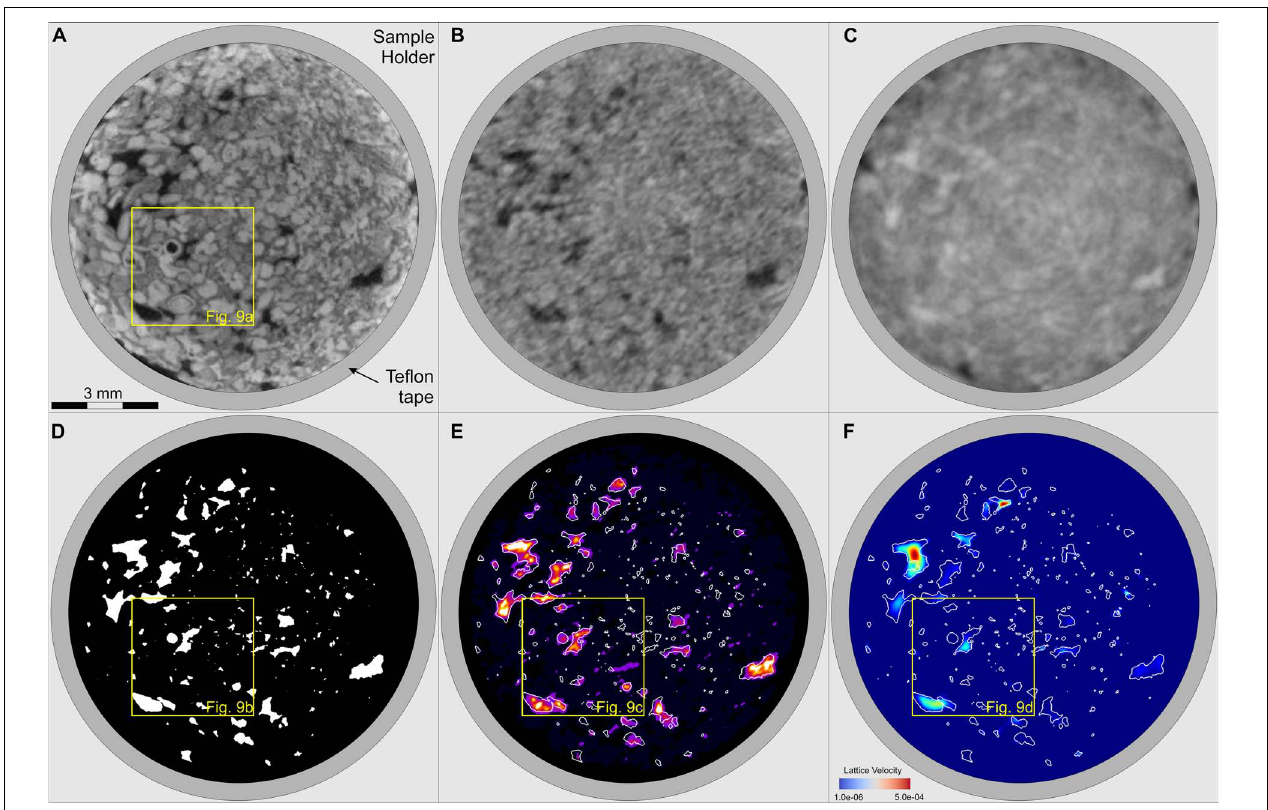
FIGURE 7 | Comparison of resulting images near the middle of the sample. (A) XCT at dry conditions, (B) NCT at dry conditions, (C) NCT at wet conditions, (D) segmented pores from XCT, (E) Difference of NCT wet-dry images using as mask the segmented macropores from the XCT data, warmer colors indicate a higher saturation of water, (F) Lattice velocity images obtained by using LBM fluid flow simulation, warmer colors indicate a higher lattice velocity of the simulated flow. The pixel size is set to 13.5 µ m for both NCT and XCT images.